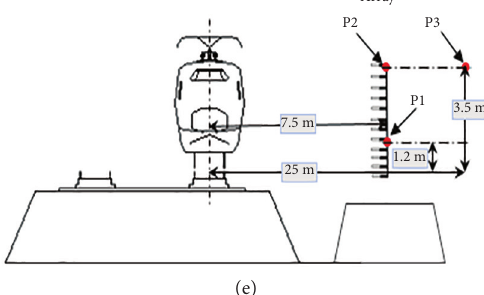
Figure 11: Microphone array measurement. (a) The array setup and running direction of the high-speed train. (b) Measurement photo in viaduct. (c) Measurement point in viaduct. (d) Measurement photo in embankment. (e) Measurement point in embankment.